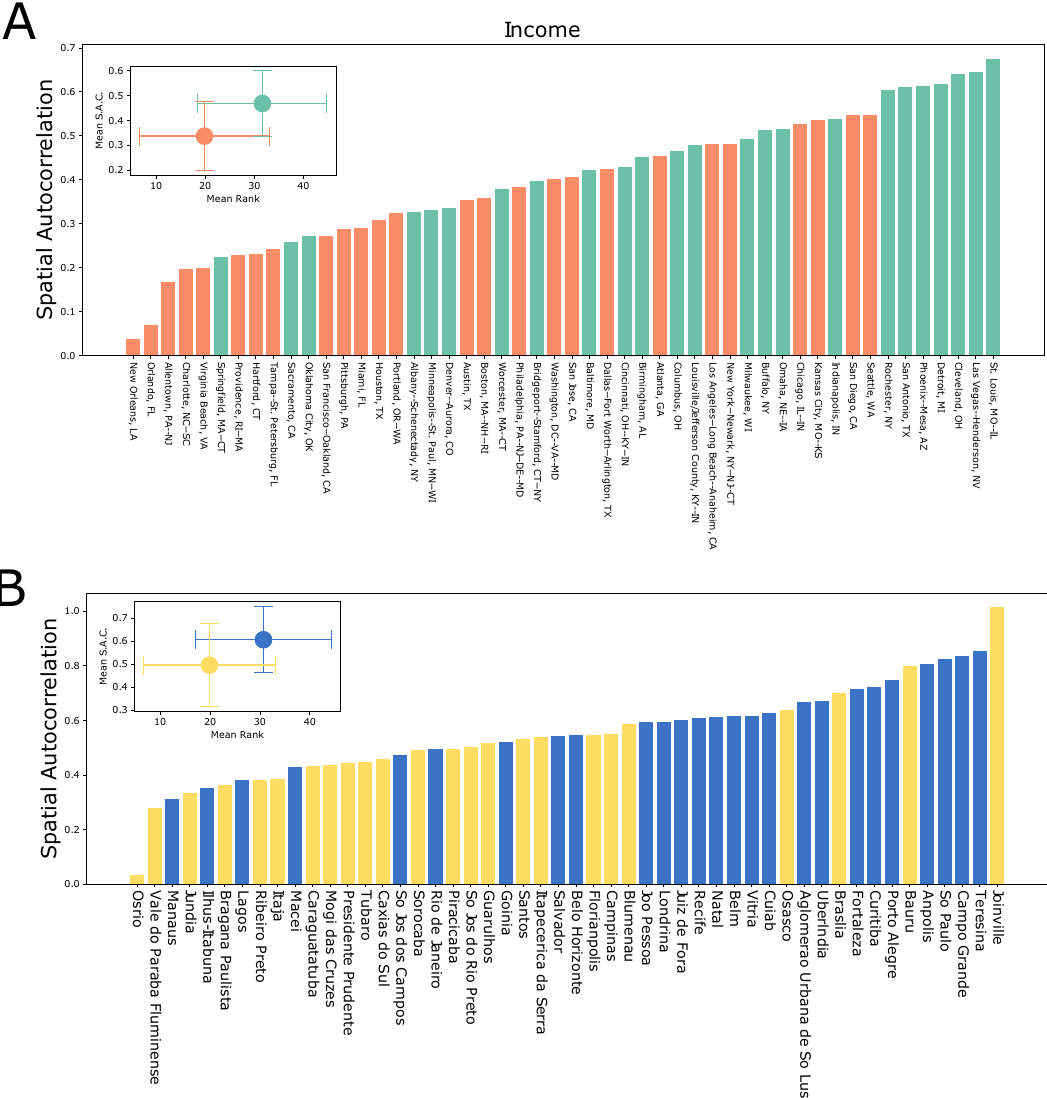
Figure 7. Income spatial autocorrelation. Ranking of Moran’s I values for cities in both the US ( A ) and Brazil ( B ) colored according to the cluster assigned. A high value ( ∼ 1 ) indicates that zip codes are grouped closely with zip codes of similar income, while a value close to 0 indicates a random arrangement. The average values for each cluster are shown as